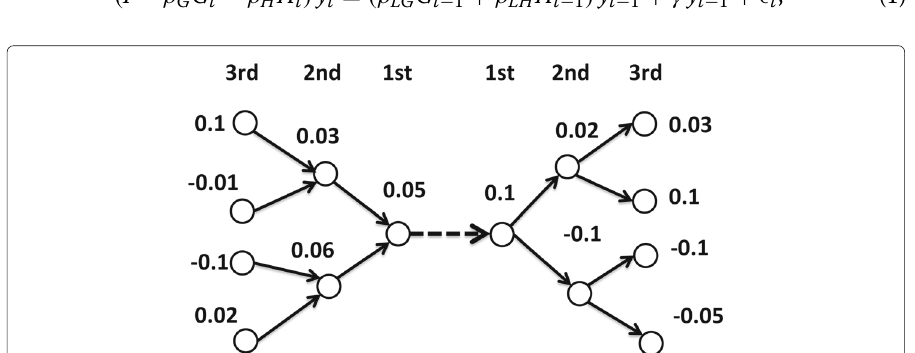
Fig. 2 Schematic diagram showing first-order, second-order, and third-order nodes of formed and severed links. Dashedlines indicate newly formed or severed links. The numbers represent the log growth rate of each